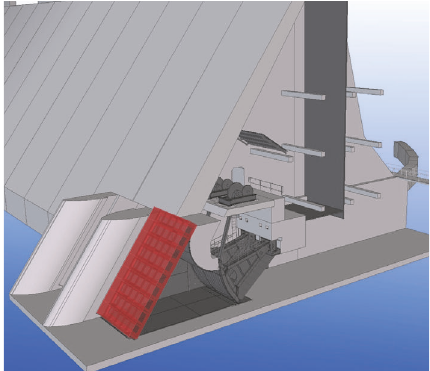
Figure 1: Layout of the bottom outlet with a radial gate and a sloping bulkhead gate for